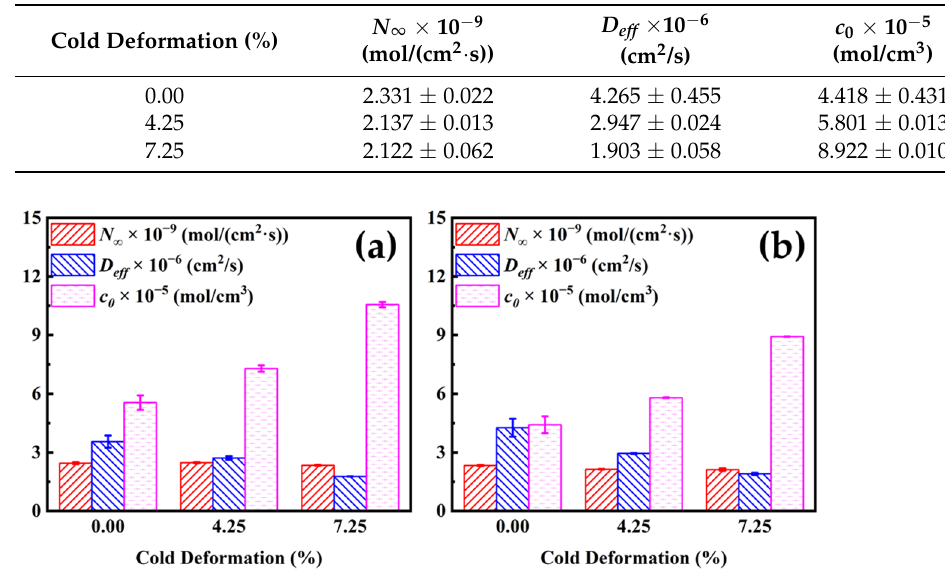
Figure 5. Effect of cold deformation on hydrogen permeation behavior: ( a ) hydrogen permeation parameters from the first permeation curves, ( b ) hydrogen permeation parameters from the second permeation curves.